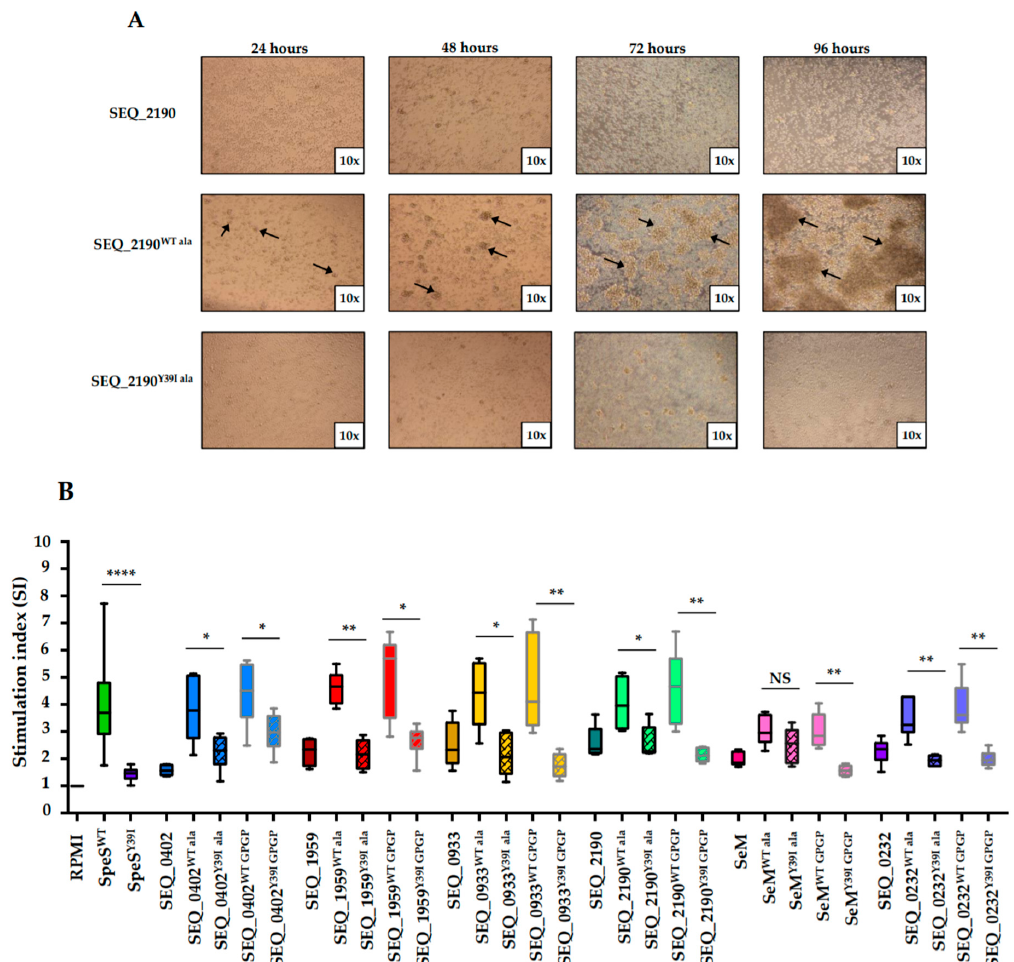
Figure 3. S. equi surface proteins fused to SpeS Y39I lack mitogenic activity in vitro. ( A ) Images of equine PBMCs cultured for 24, 48, 72 and 96 h with 1 µ g / mL of SEQ_2190 or SEQ_2190 fused to SpeS WT or SpeS Y39I . Images are representative of all the S. equi surface proteins and fusion proteins used. Photos of the cells were taken with a camera at 10 × magnification. Pointed arrows show the clusters of cells formed after being exposed to the SpeS WT fusion protein. ( B ) Equine PBMCs (1 × 10 6 cells / mL) from two di ff erent donors were stimulated in triplicate with 1 µ g / mL of the S. equi surface proteins alone or as fusion proteins for four days. 3 HT was added for 16 h before measuring the proliferation of cells. SpeS WT , SpeS Y39I and medium alone were used as controls. Results are presented as SI. Data is from three independent experiments. Error bars correspond to SEM. * p ≤ 0.05, ** p ≤ 0.01, **** p ≤